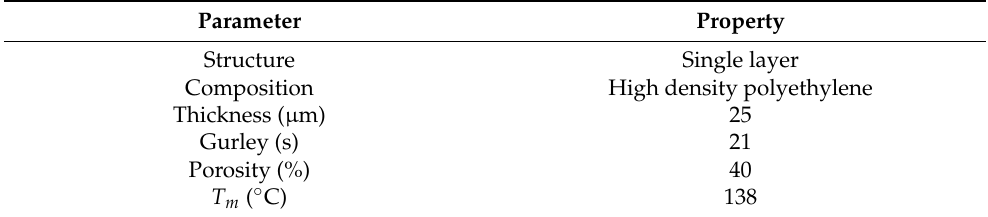
Table 2. Specifications of porous substrate used in this work [21].